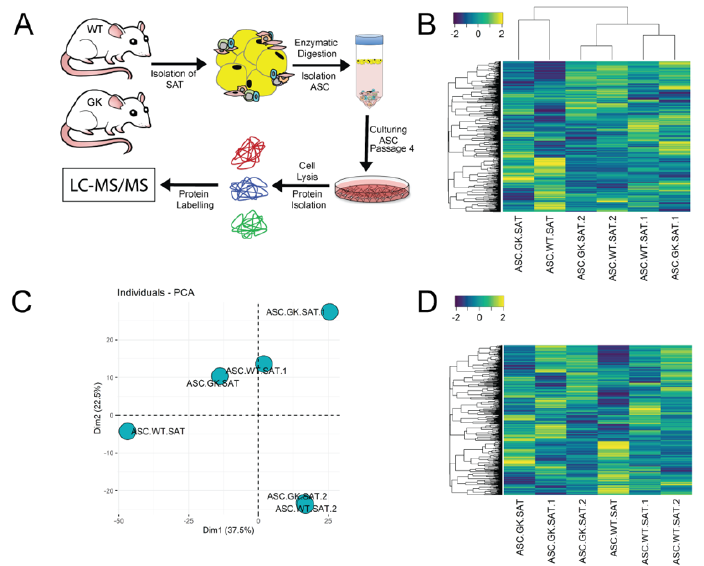
Figure 2 . Quantitative proteomic analysis on ASCs from WT and GK rats. ( A ) Schematic represen- tation of the TMT proteomic study. ( B , C ) Cluster analysis of proteins expressed in ASC WT (n = 3) and ASC GK (n = 3) with heatmap analysis was performed in “R”. Heatmap ( B ) and PCA plot ( C ) showing no association between samples. ( D ) Heatmap with no dendrogram clustering of samples. The legend color bar in ( B , D ) indicates the relation between scaled ratios and colors.